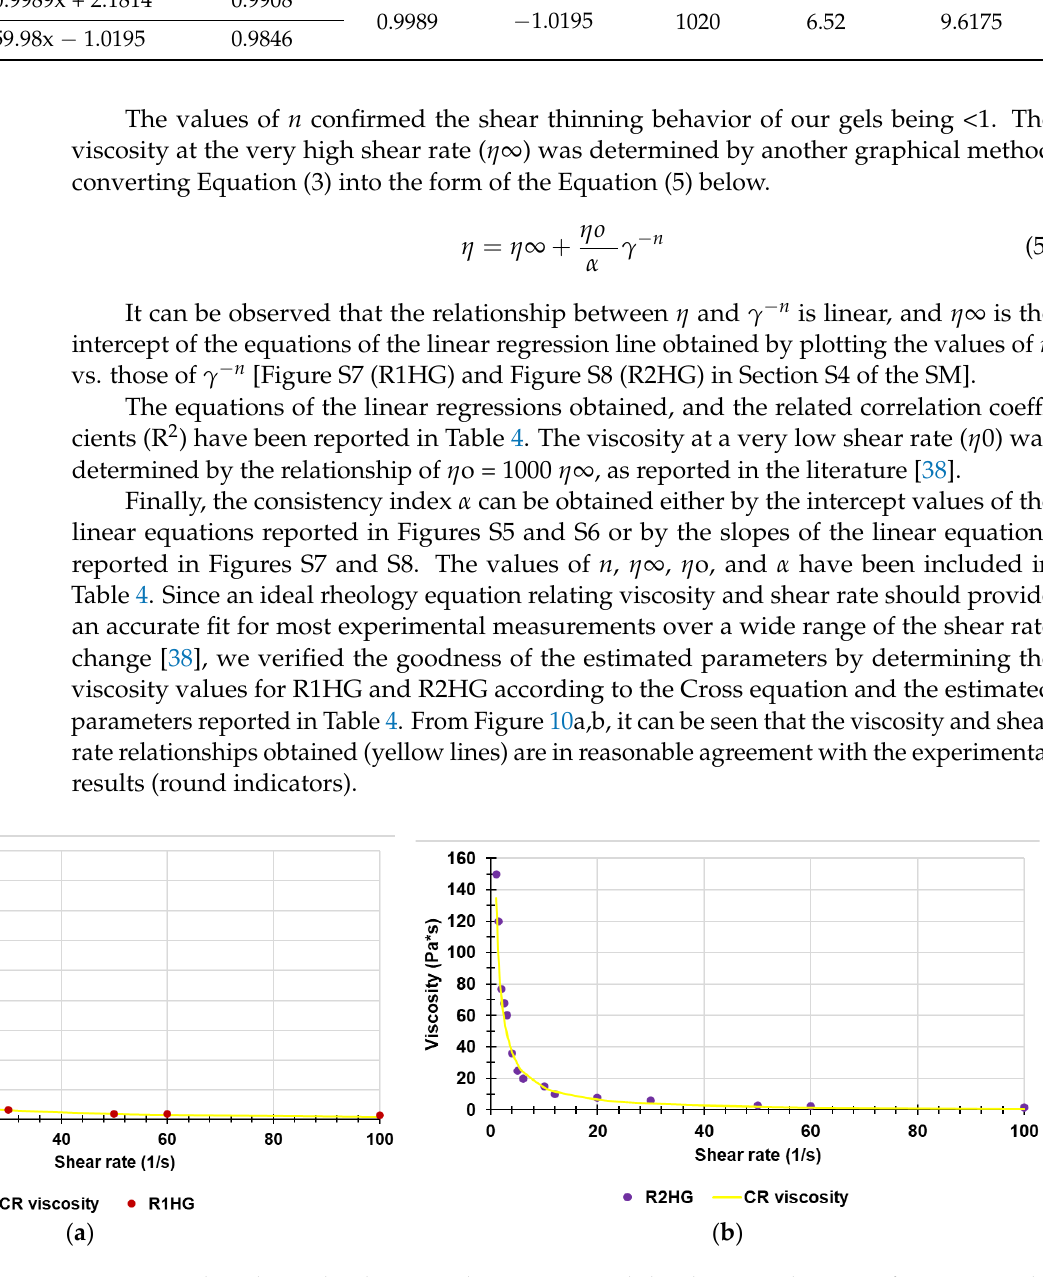
Figure 10. The relationship between the viscosity and the shear rate by Cross fitting using the proposed method for R1HG ( a ) and R2HG ( b ) (yellow lines) and experimental measurements (red and purple round indicators).